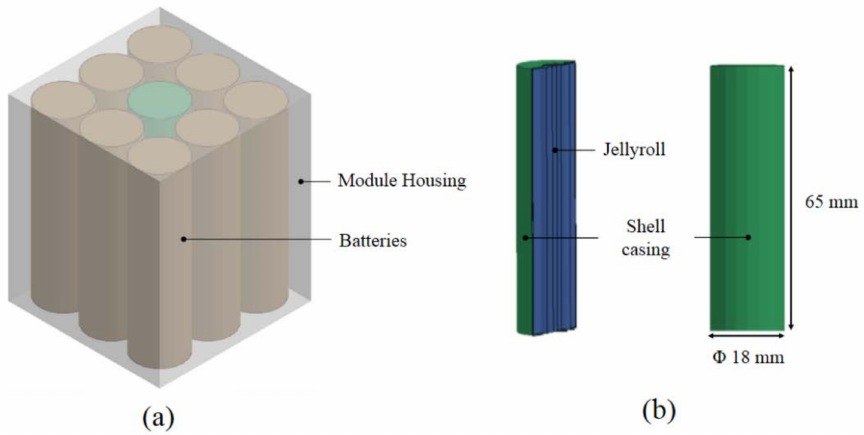
Figure 2. Battery ( a ) module model and ( b ) 18650 model